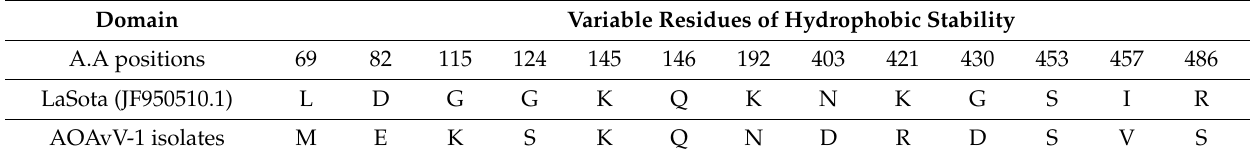
Table 4. Analysis of mutations in the predicted positions contribute to hydrophobic stability of the F protein in our AOAvV-1 isolates reported in this study compared to the LaSota vaccine.